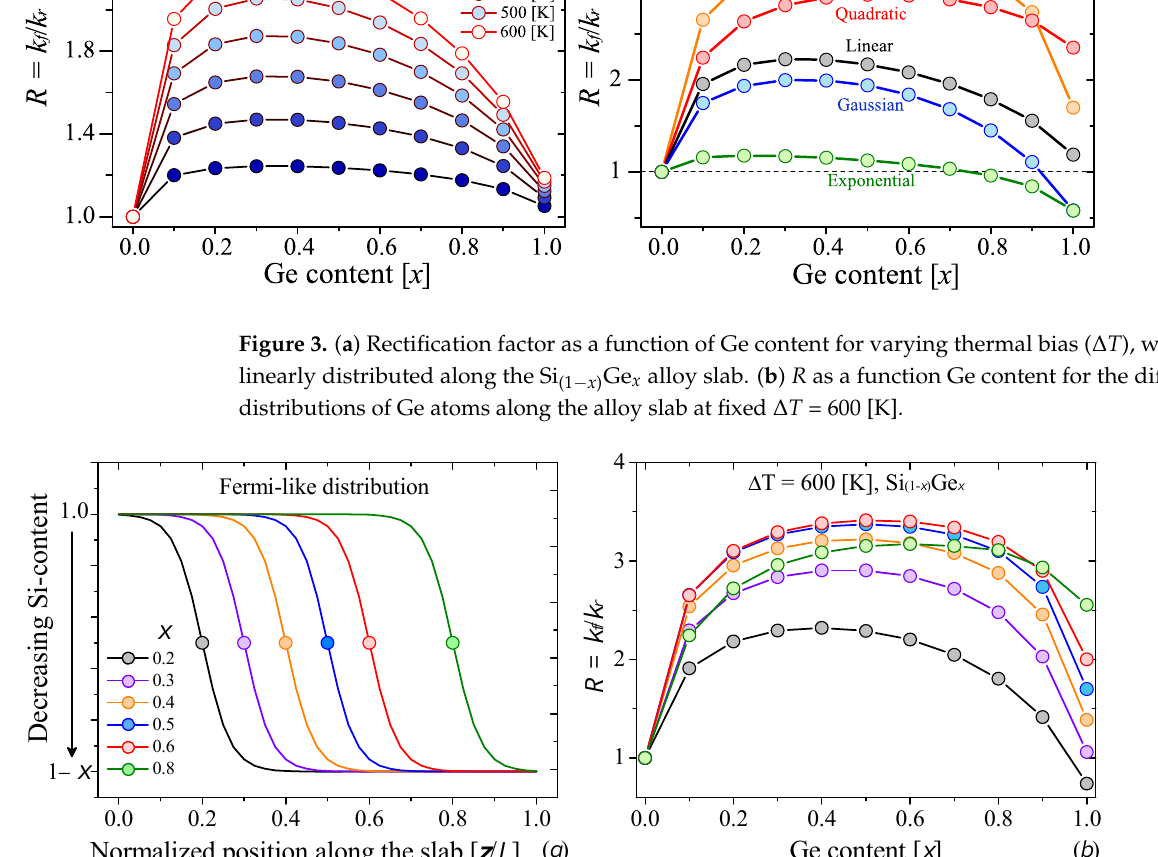
Figure 4. ( a ) Fermi-like spatial distribution of Si (or Ge) atoms along the length of the Si (1 − x ) Ge x alloy slab ( z ). The color scale represents varying values of x . The solid dots represent the half-point of the Fermi-like distribution in x . ( b ) Rectification factor as a function of the position along the slab for alloy slabs of varying composition presented in ( a ). The color scheme is consistent throughout the figure.